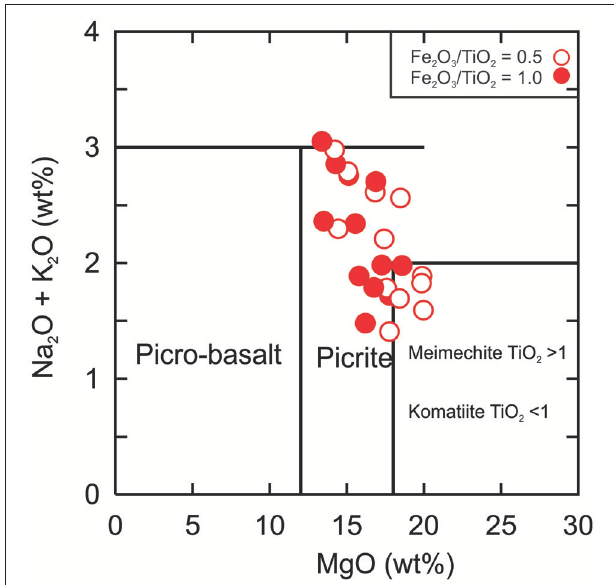
FIGURE 2 | Classification of the primary liquid composition calculated in this study using the scheme of Le Bas (2000). Data compiled from Song et al. (2001); Xiao et al. (2004); Zhang et al. (2006); Wang et al. (2007); Zi et al. (2008) , and Arguin et al. (2016).